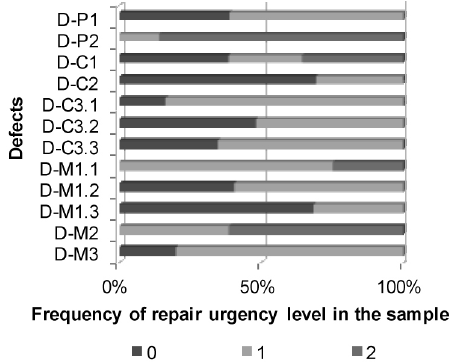
Fig. 7. Frequency of repair urgency level for each type of defect in the